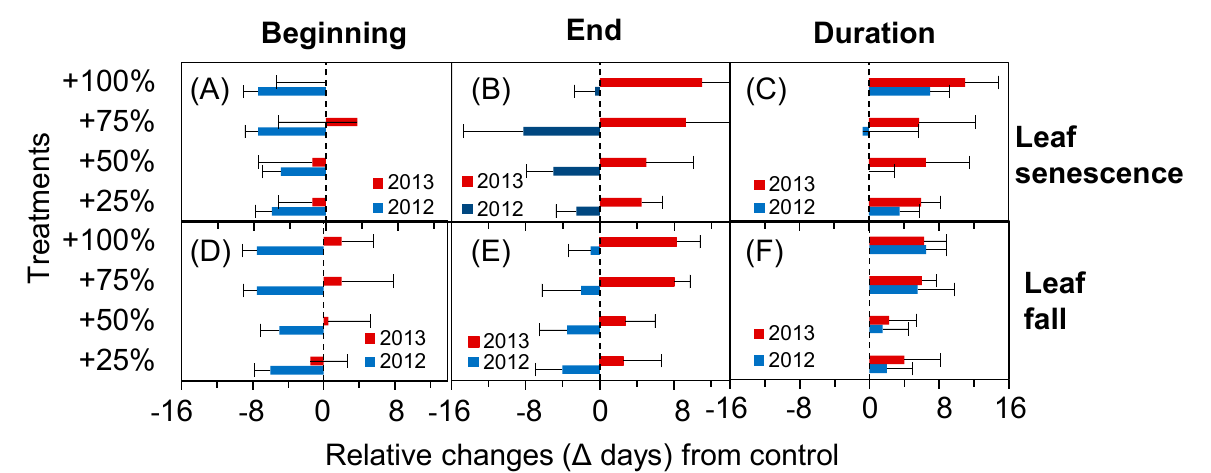
Figure 5. Effect of the simulated enhancement of precipitation on the time of the beginning ( A , D ), end ( B , E ), and duration ( C , F ) of the autumn phenological events.